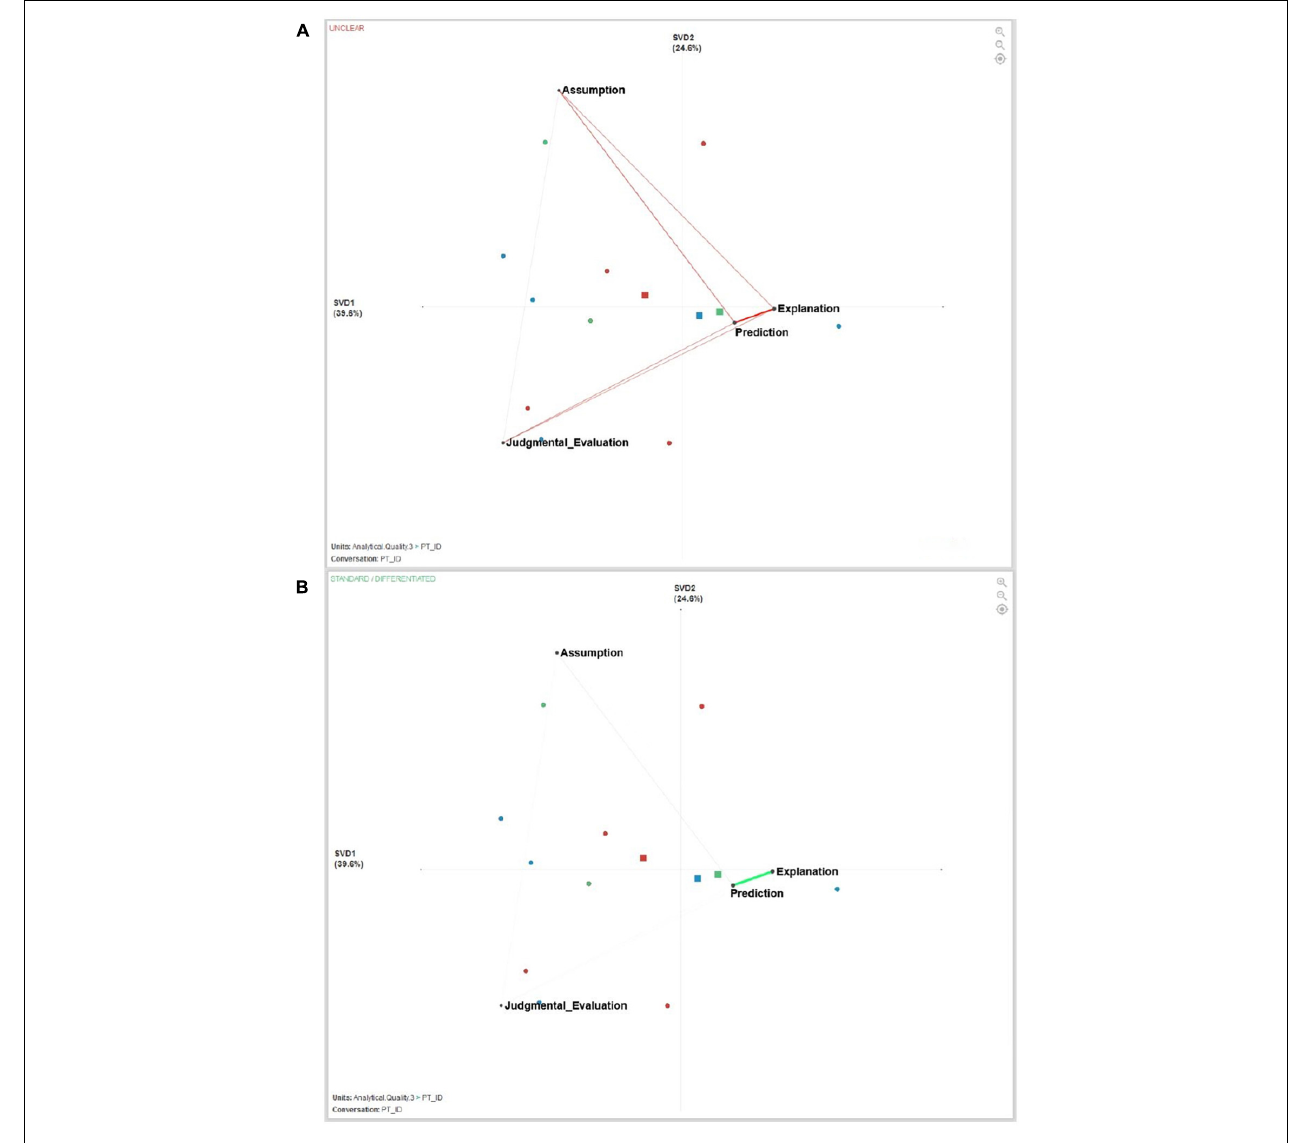
FIGURE 7 | (A,B) Unclear and standard/differentiated interpret mean networks. These Figures show the unclear quality group mean network for the interpret indicators ( A : top, red; n = 34 participants), and the standard/differentiated quality group mean network for the interpret indicators ( B : bottom, green; n = 19 participants). Only the unclear and standard/differentiated mean networks are fully shown here to demonstrate differences at the extremes (the vague group mean centroid is still depicted here as the blue square). As shown in Figure 6 , the vague mean network falls between the unclear and standard/differentiated